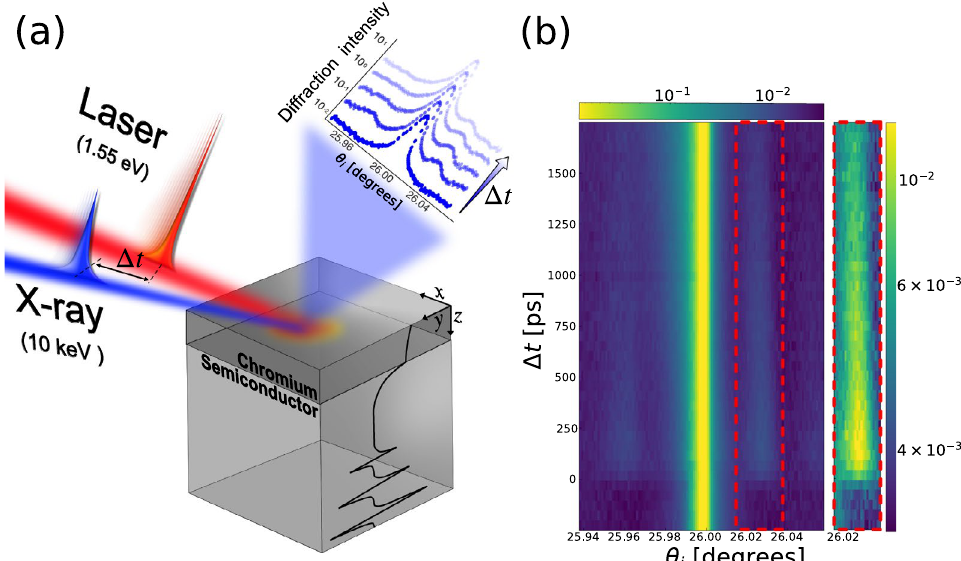
Figure 1. ( a ) Schematic of the TRXD experiment of metal layered semiconductor, and ( b ) time- and angle- resolved intensity profiles of the obtained GaAs (0 0 4) Bragg diffraction peak. The red dashed box indicates the region of interest where the intensity modulation along the angular axis is detected due to X-ray Brillouin